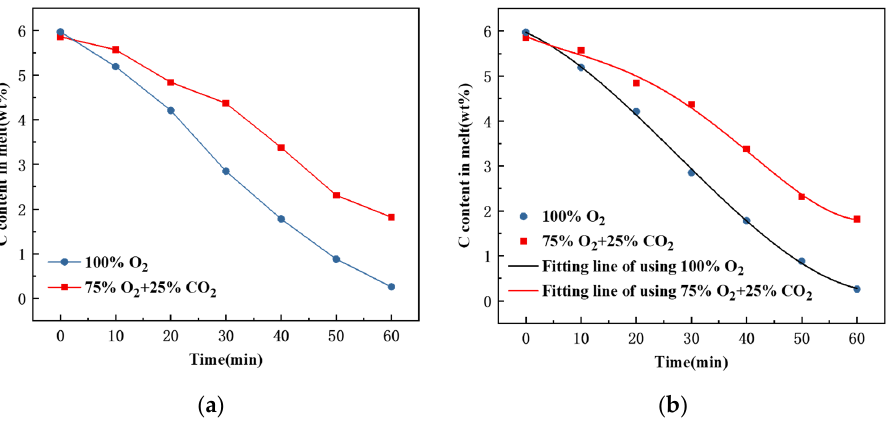
Figure 12. Variation in carbon content in melt when blowing 25%CO 2 + 75%O 2 and pure %O 2 : ( a ) variation in C content with time; ( b ) fitted curve of variation in C content with time.